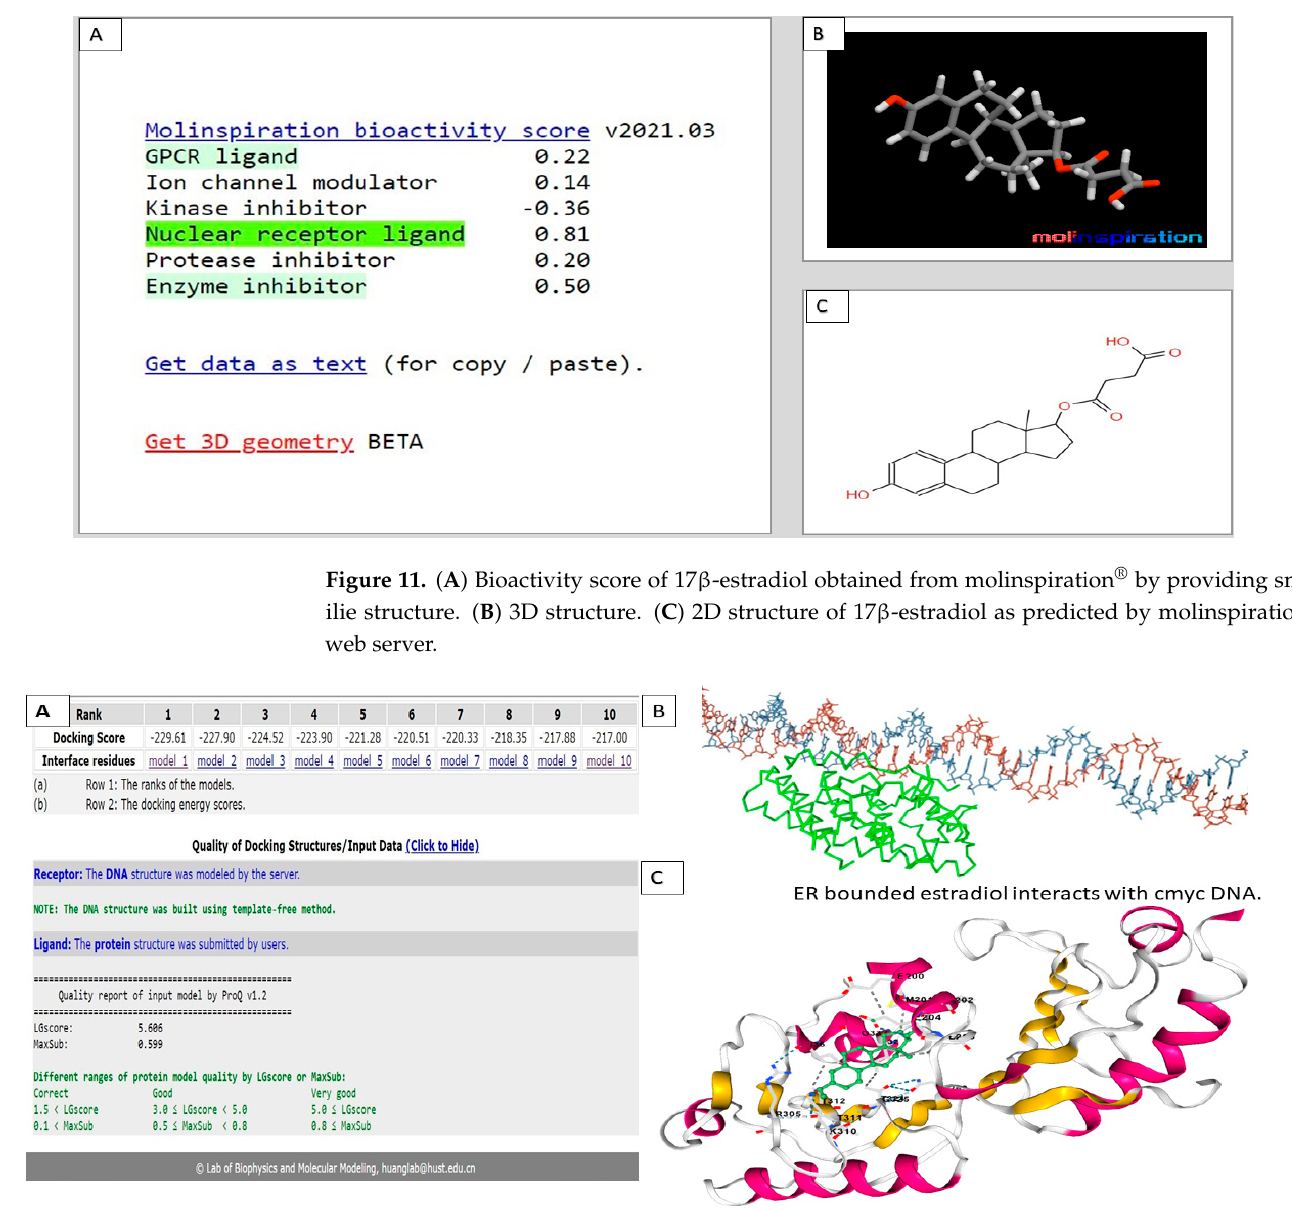
estradiol with c-myc gene 67 kb upstream of the promotor region at lowest energy score of − 229 kcal/mol